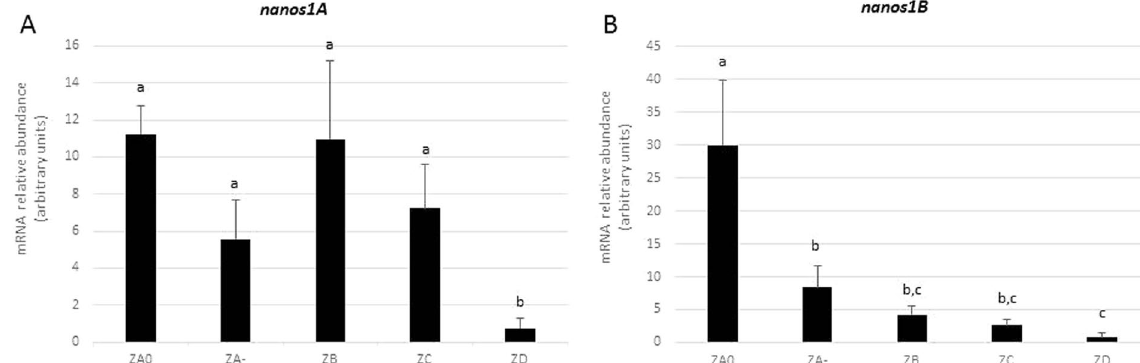
Figure 4. Specific expression patterns of nanos1A and nanos1B in dogfish testicular zones. The relative abundance of nanos1A and nanos1B mRNAs in the five testicular zones was measured by RT-PCR and normalized with 5S rRNA . Dogfish polarized testis was dissected in five zones from its dorsal to its ventral side: ZA0, germinative zone containing SSCs; ZA-, cysts with spermatogonia; ZB, meiotic zone; ZC, cysts with round-spermatids; and ZD, cysts with elongated spermatids and zone of cyst resorption. The nanos1A transcript was detected in all zones except in zone D where it was almost undetectable. In contrast, nanos1B showed a marked progressive decrease of its expression after the germinative zone, ZA0. Data are presented as mean + SD (N = 4). Differences in gene expression were evaluated using one-way analysis of variance followed up with Games-Howell test. Testicular zones sharing no letter in common show significantly different expression levels.